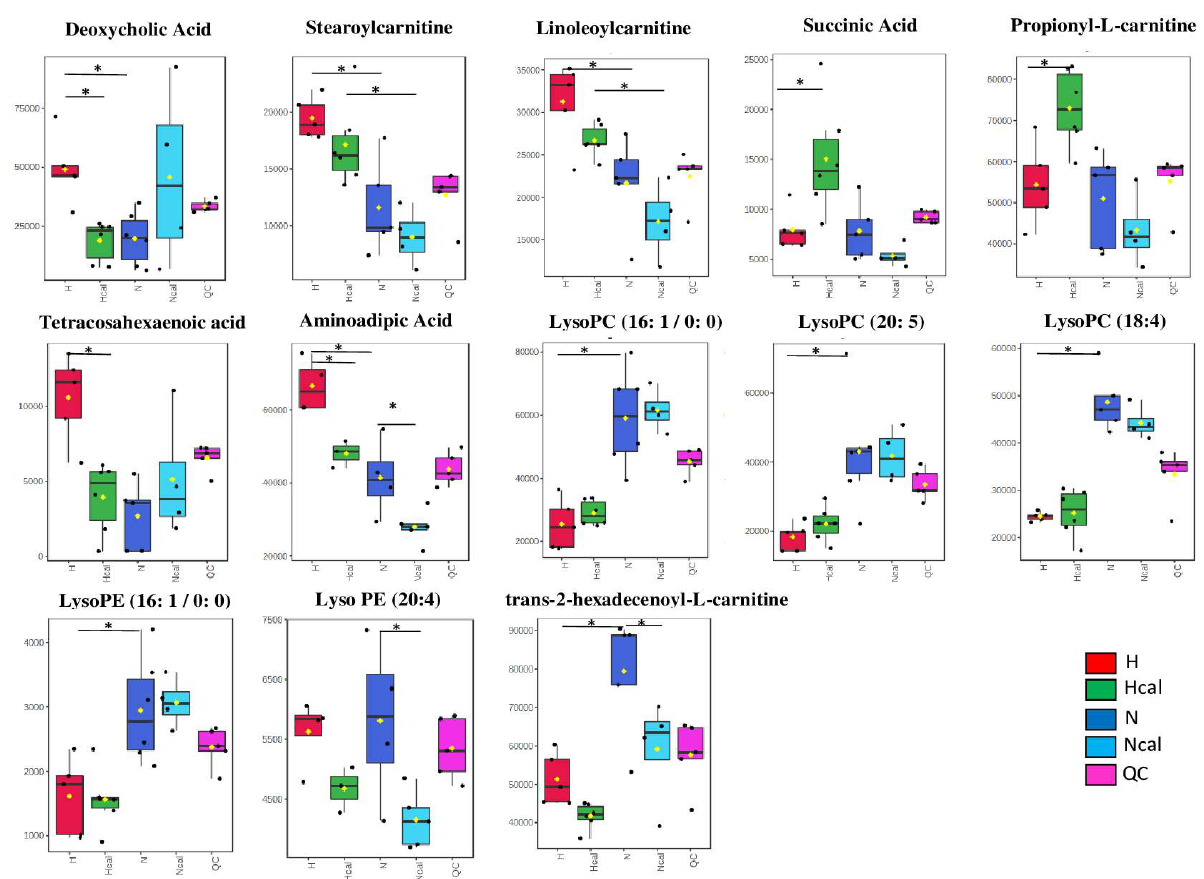
Figure 3. Box plot features significantly (* p < 0.05) identified. H in red, Hcal in green, N in blue, Ncal in light blue and QC in pink. H—High-fat diet group; N—normal diet group; Hcal—High-fat diet group with calafate; Ncal—Normal diet with calafate; QC—Quality control. Y-axis corresponds to the peak area. Stearoyl-L-carnitine (N°9: [M+H]+ 428.3702 m/z) and linoleoyl-L-carnitine (N°11: